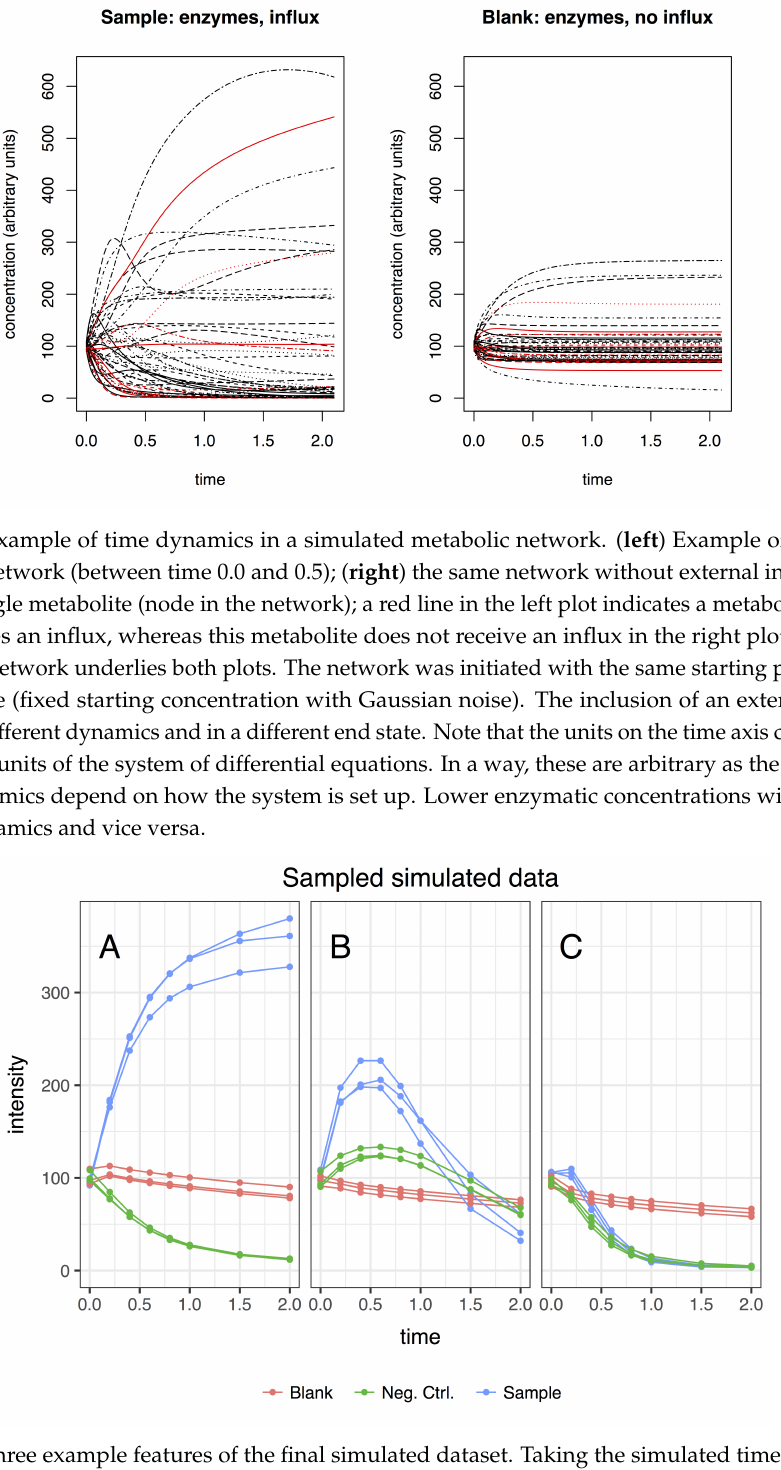
Figure 6. Three example features of the final simulated dataset. Taking the simulated time dynamics data in Figure 5, sampling these data and combining them by sample results in the final dataset to be used for EDGE and tinderesting. A single green line corresponds to the sampled data of a single continuous metabolite concentration signal (one line in the left of Figure 5). That same metabolite sampled in the right half of Figure 5 results in a single red line in this image. The three lines of each class are the replicates (i.e., same network, slightly different starting conditions because of noise). ( A ) A typical curve of metabolite formation; ( B ) an intermediary biotransformation; and ( C ) an uninteresting feature (sample class shows identical behavior as an other